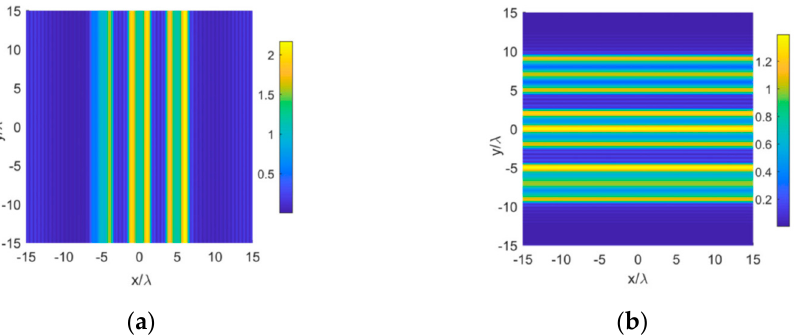
Figure 12. Reconstructed pictures for Case 3. Sample on a linear grid right above the source along the ( a ) x -direction and ( b ) y -direction.